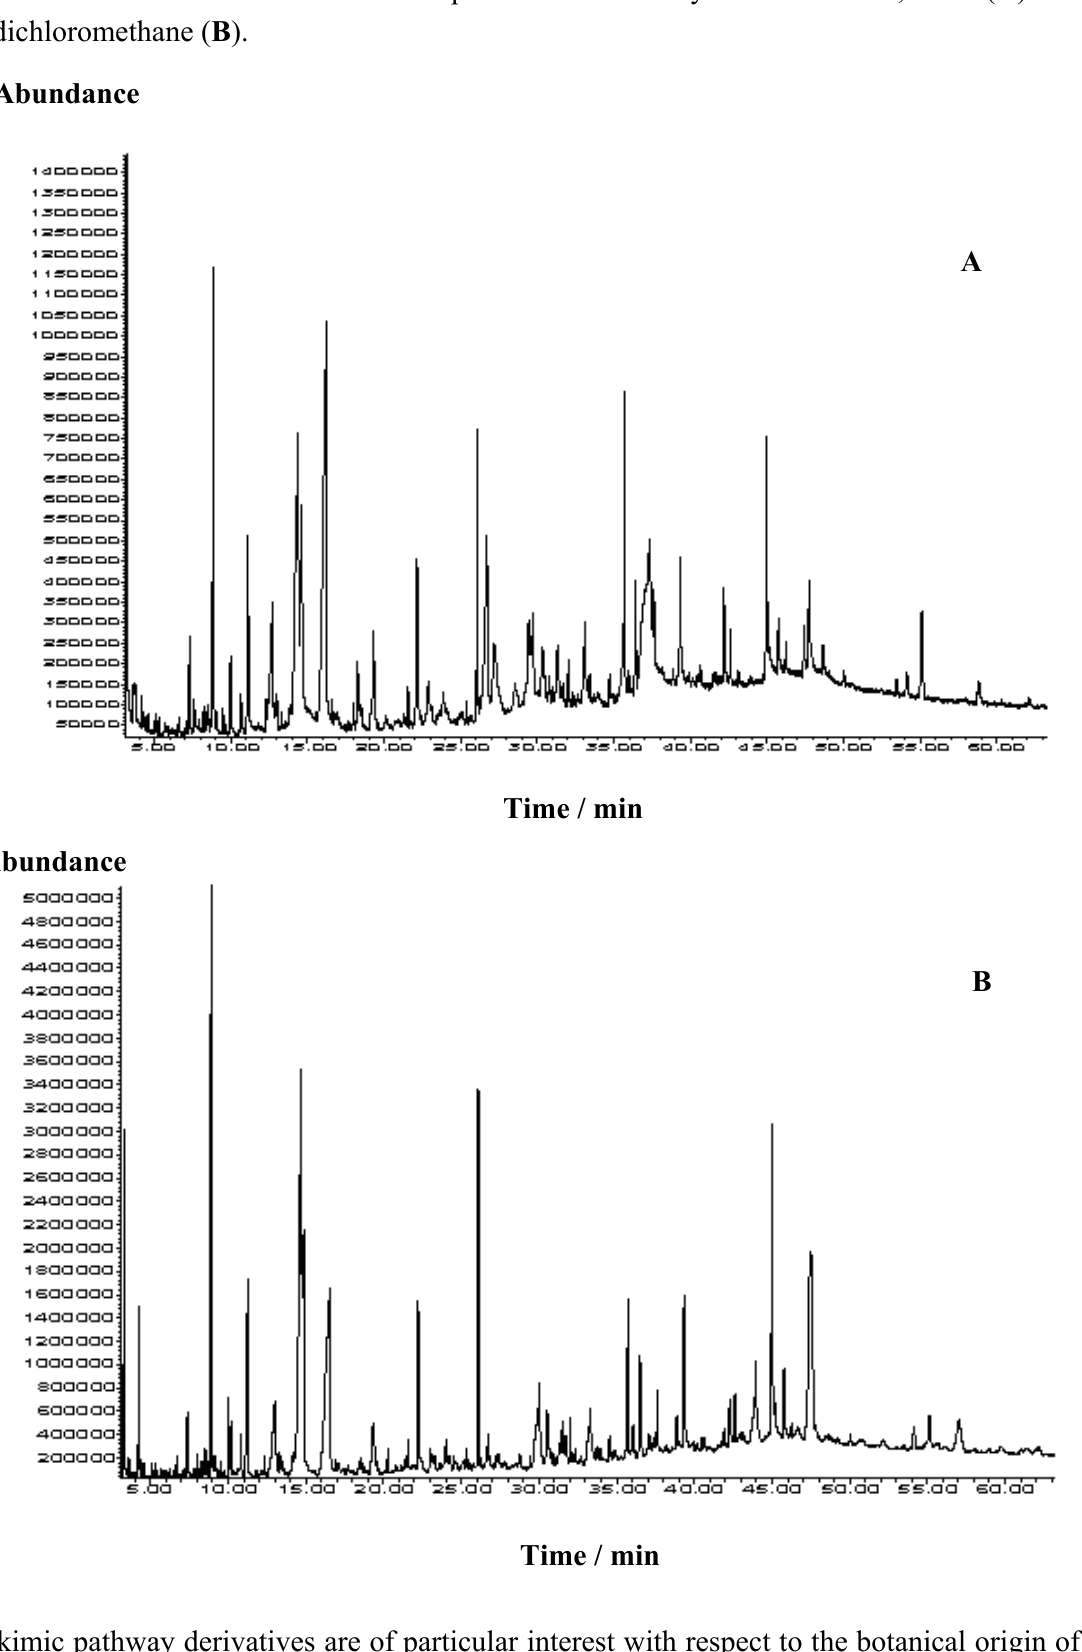
Figure 1. Representative TIC chromatogram of oak honeydew USE extracts of the sample II obtained with the mixture of pentane and diethyl ether 1 : 2, v/v ( A ) and dichloromethane ( B